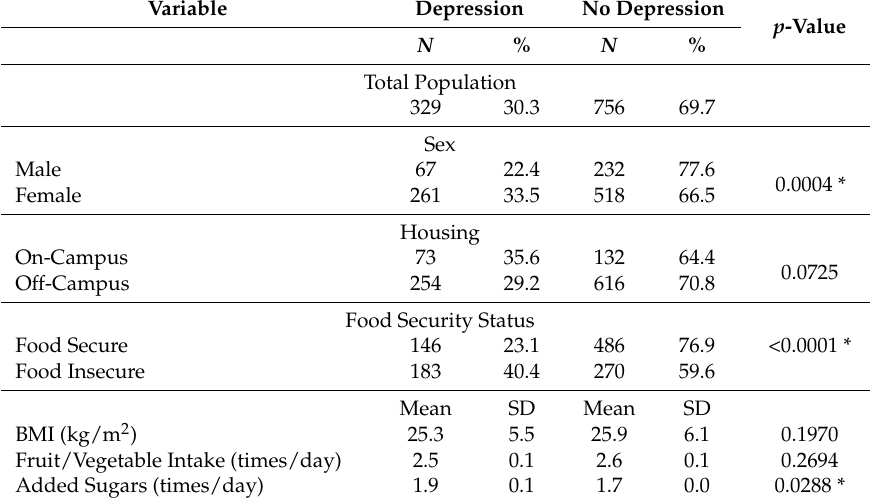
Table 1. Characteristics of respondents and correlations with depression status.